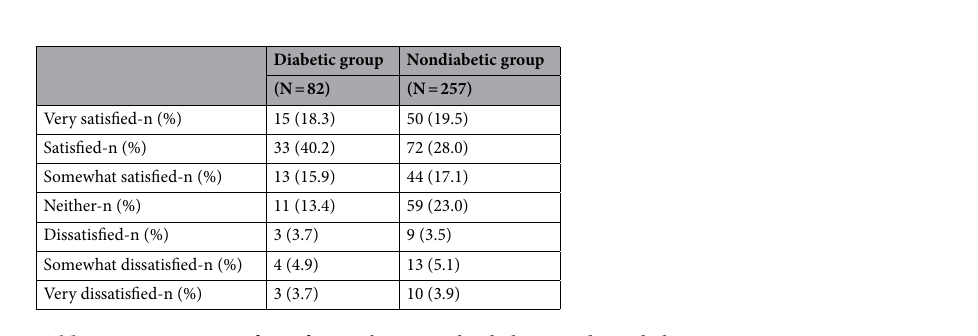
Table 5. Comparison of satisfaction between the diabetic and nondiabetic